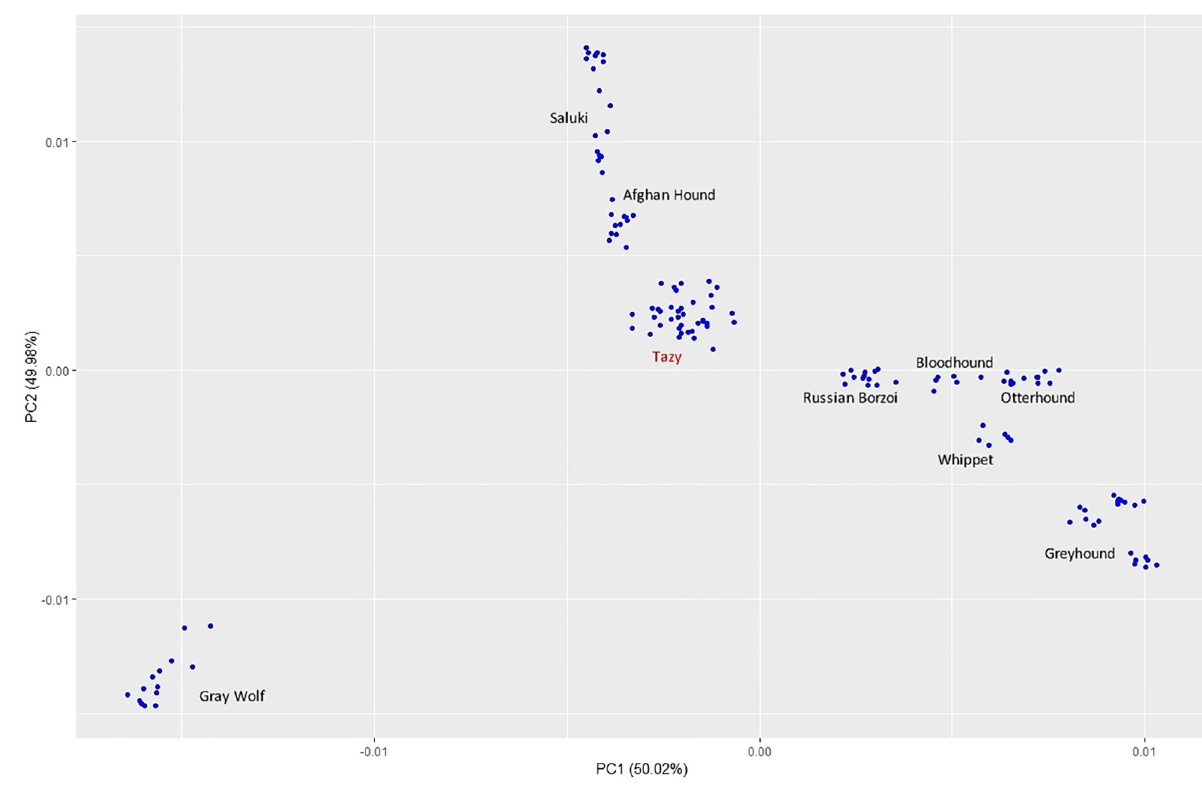
Fig 5. Dog clustered based on PCoA using individual SNP genotypes. Plot for the first (PC1) and second (PC2) component revealed the clustering of 39 Tazy dogs, 74 dogs from seven sighthound breeds and 14 Grey Wolves.